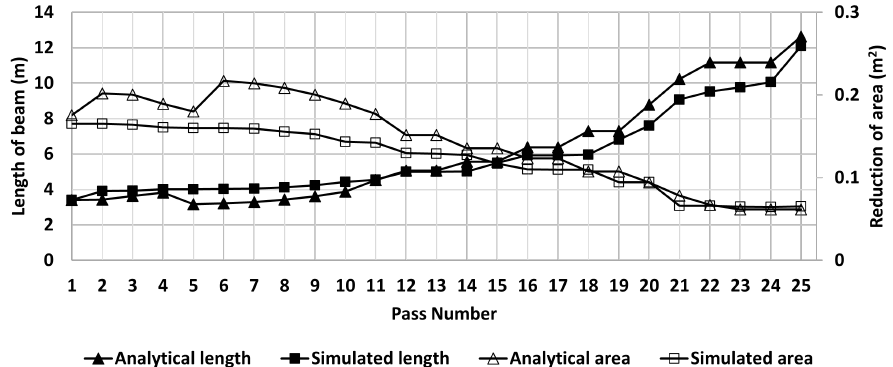
Figure 4. Comparison between analytical results and numerical results of the beam length at each pass.